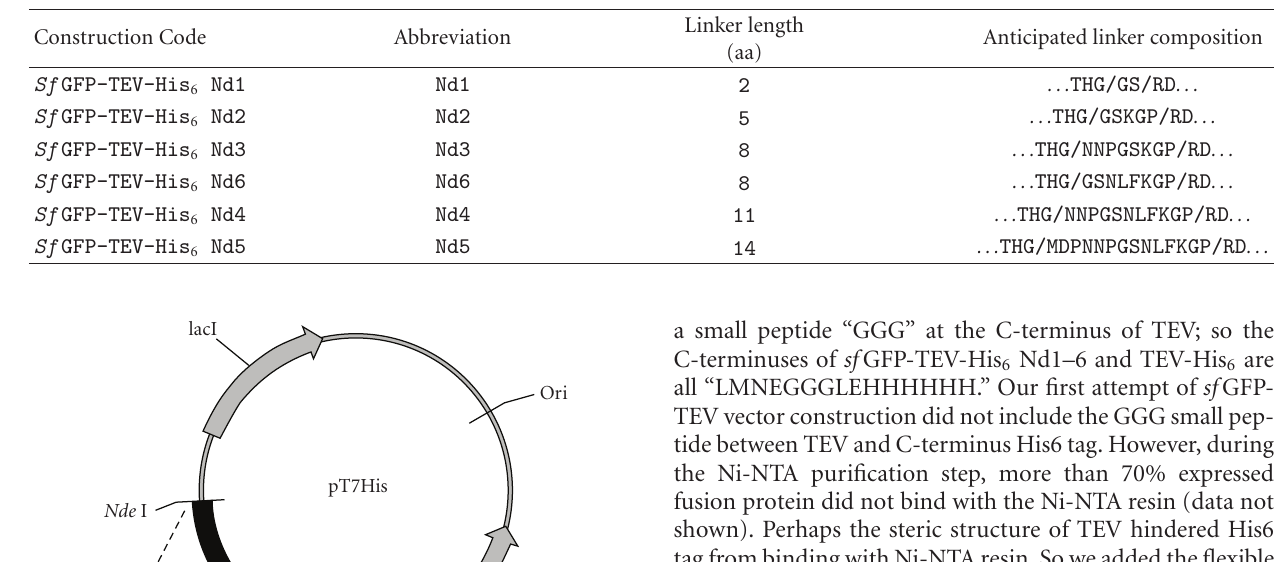
Table 2: Linker region of sf GFP-TEV-His 6 Nd1–6.